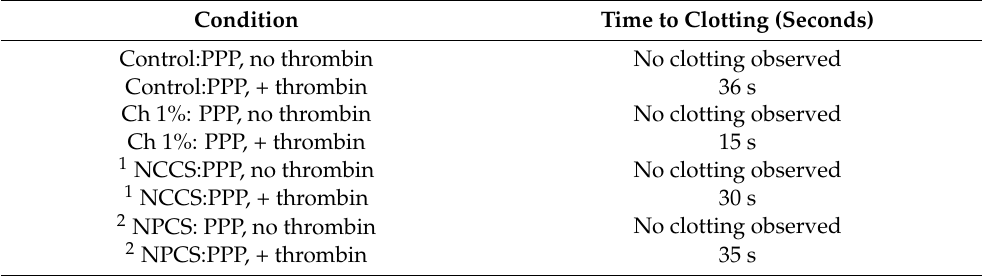
Table 2. Hemostatic Essay Results. Condition Time to Clotting (Seconds) Control:PPP, no